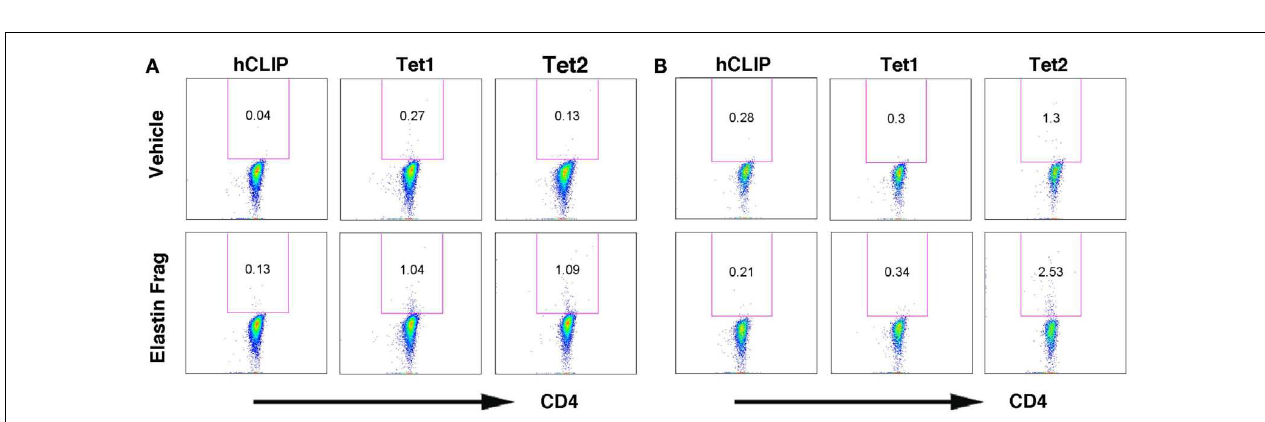
well as a non-specific tetramer hCLIP (DRB1-0101/PVSKMRMATPLLMQA) are shown. Relative % abundance of tetramer positive CD4 + T cells is shown above each of the gated area in the plots. Representative of a subject showing (A) approximately 10-fold increase or (B) moderate increase in relative % abundance ofTet1 andTet 2 in response to EFs stimulation. Data are representative of three independent